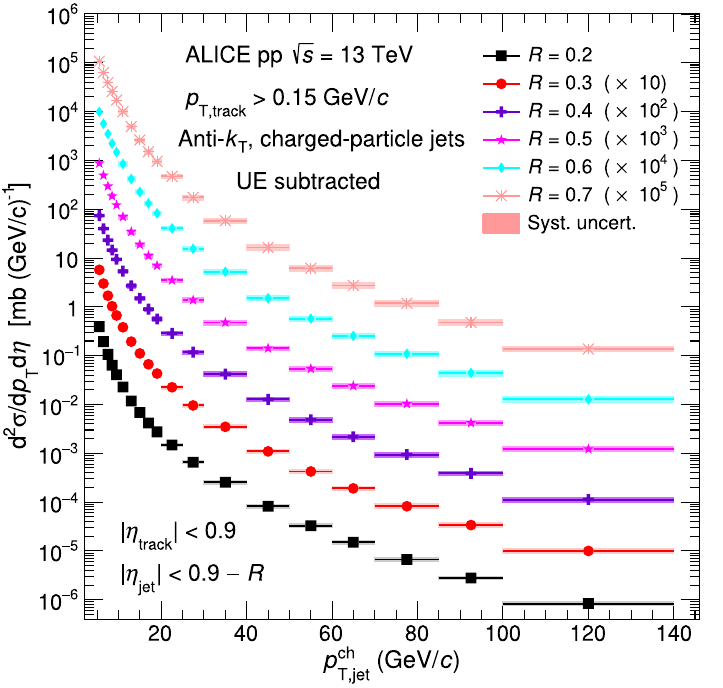
Fig. 3 Inclusive charged-particle jet cross sections in pp collisions at √ s = 13 TeV using the anti- k T algorithm for different jet resolution parameters R from 0 . 2 to 0 . 7, with UE subtraction. Statistical uncer-